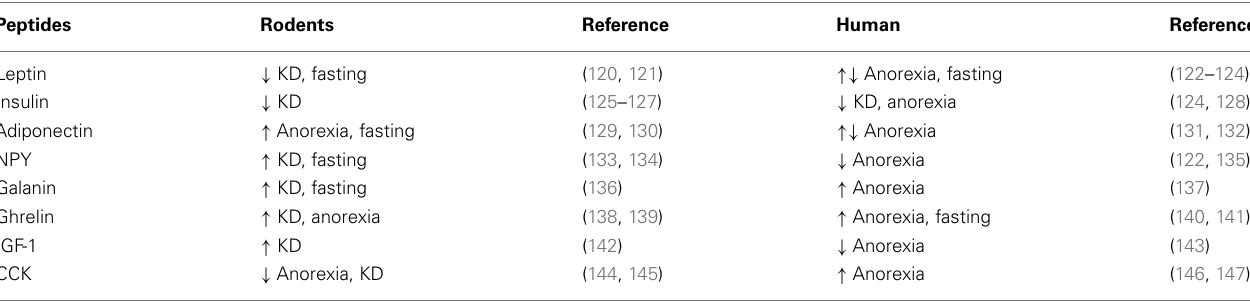
Table 3 | Changes in different neuroactive peptide levels in animals and humans during various metabolic states, including anorexia, prolonged fasting, or a ketogenic diet (KD)